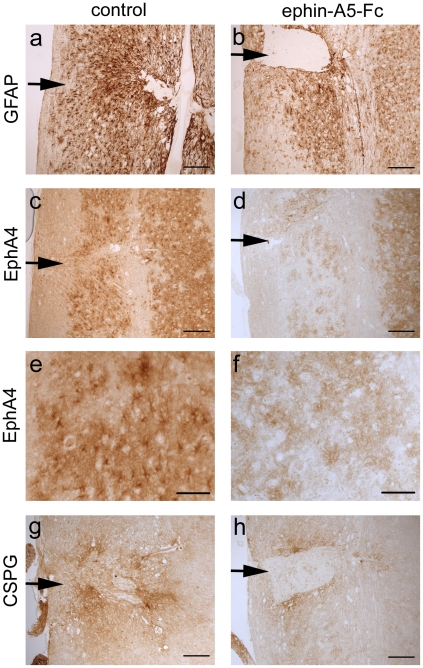
EphA4 immunostaining is decreased adjacent to injury site in ephrin-A5-Fc treated mice.Immunohistochemical analysis of (A,B) GFAP, (C–F) EphA4 and (G,H) CSPG expression at 2 weeks after spinal cord hemisection and 2 weeks of ephrin-A5-Fc treatment indicated that there was robust GFAP staining in both treated and control mice (A,B). However, in treated mice ipsilateral astrocytes adjacent to the injury site had markedly decreased EphA4 staining (C–F). There was also moderately decreased CSPG staining adjacent to the injury site of treated mice (G,H). Arrows indicate lesion site. Scale bars in A–D, G,H, 100 µm; E,F, 50 µm.